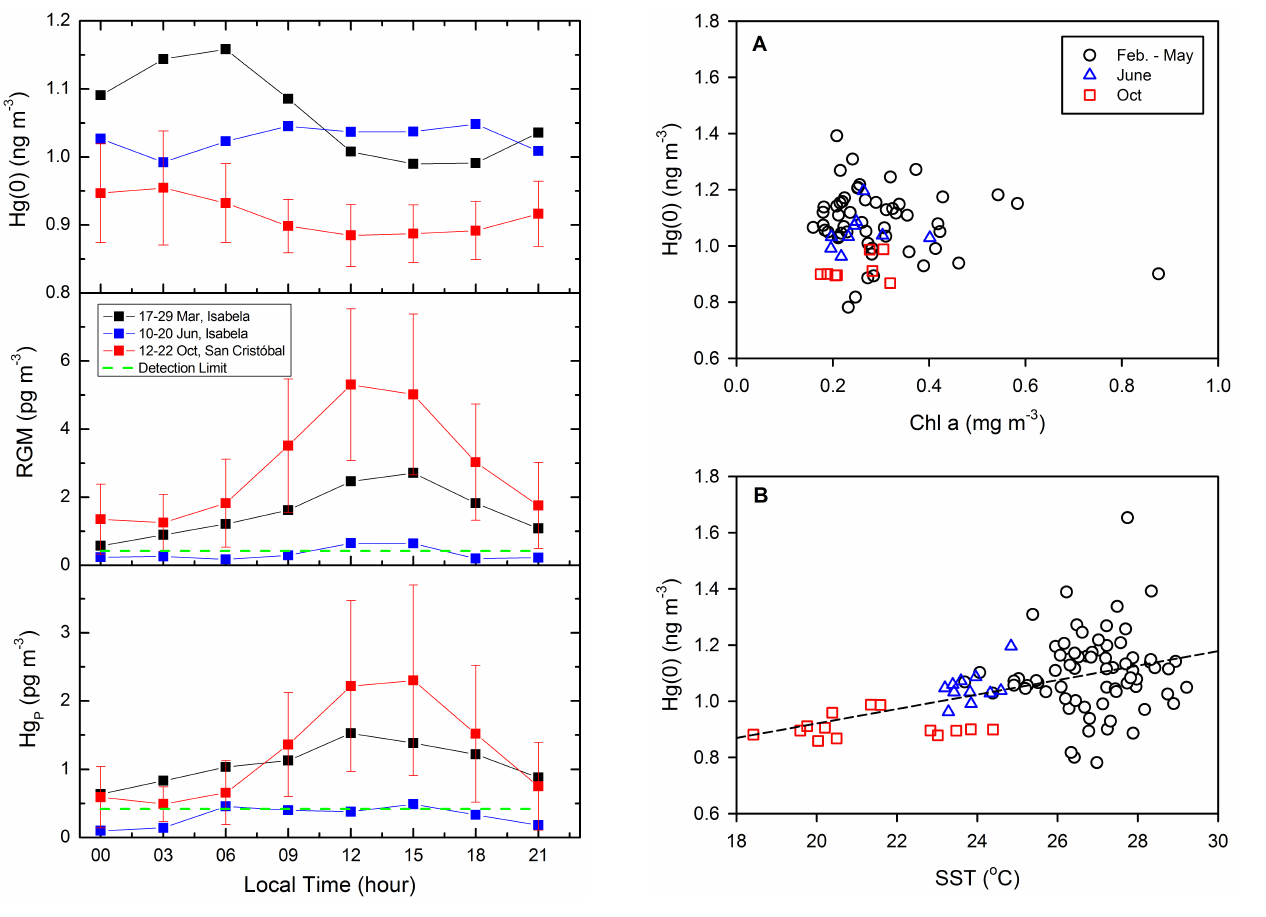
Fig. 4. Diurnal variations (3h average) in atmospheric Hg(0), reac- tive gaseous mercury (RGM) and particulate mercury (Hg P ) mea- sured on the Galápagos Islands over three different seasons. For simplicity, error bars (standard deviations) are shown only for the October data. Dashed lines show the respective detection limits.